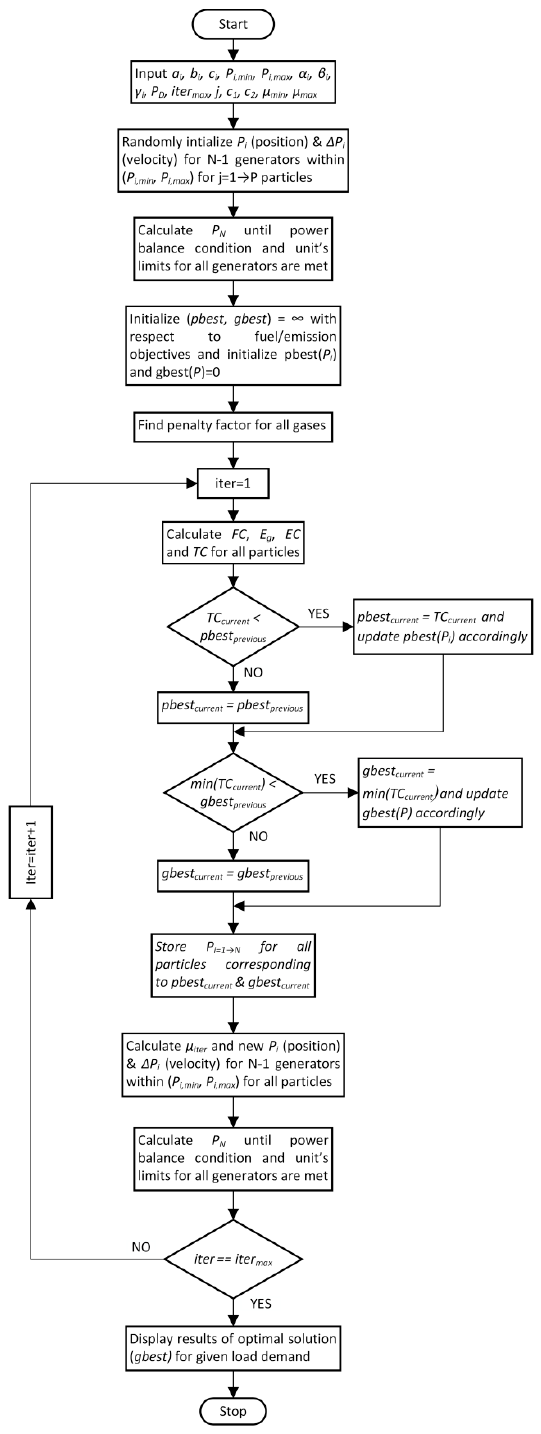
Figure 2. Implementation of combined economic emission dispatch (CEED) using particle swarm optimization (PSO) algorithm.